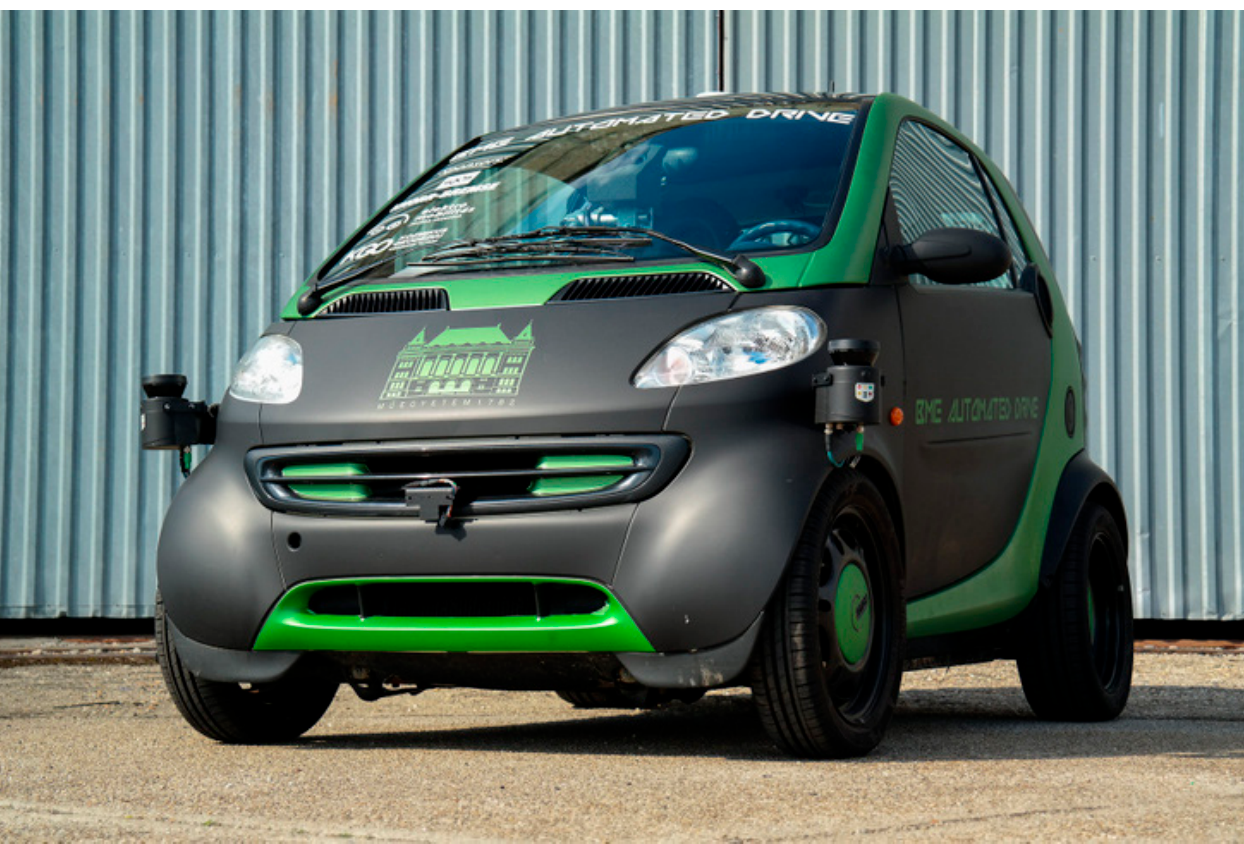
Figure 3. BME Automated Drive self-driving Smart [48].